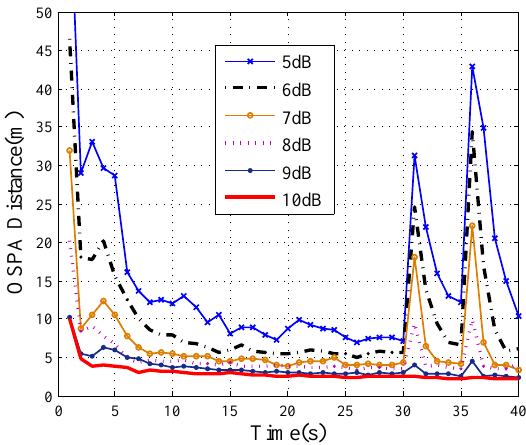
Figure 12. The OSPA miss distance at different SNRs for S-LMB-GOM